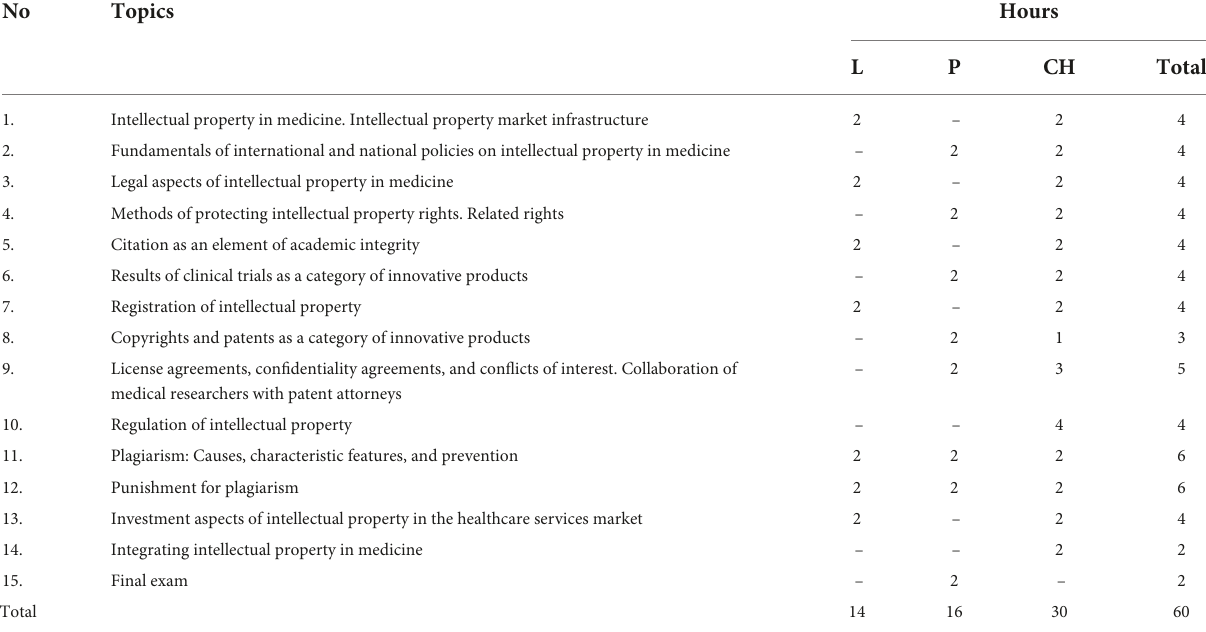
TABLE 1 Structure of intellectual property in medicine